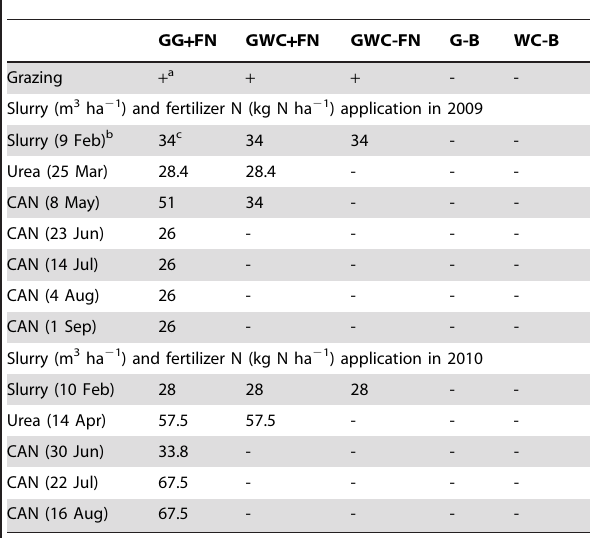
Table 1. Grazing and application of slurry and fertilizer N in 2009 and